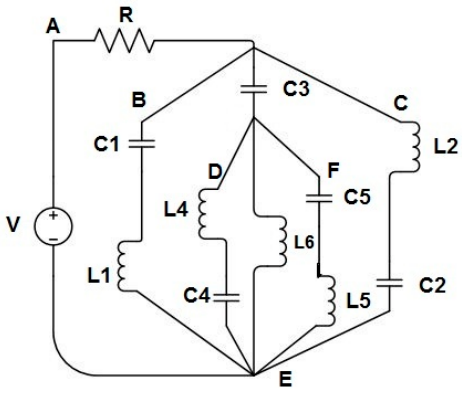
Figure 6. Equivalent circuit model of the proposed meta-atom structure.